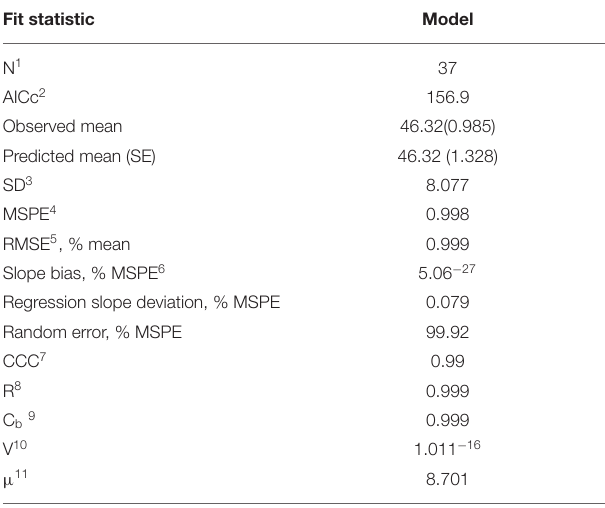
TABLE 3 | Evaluation of model equation for BAC (%) in avian